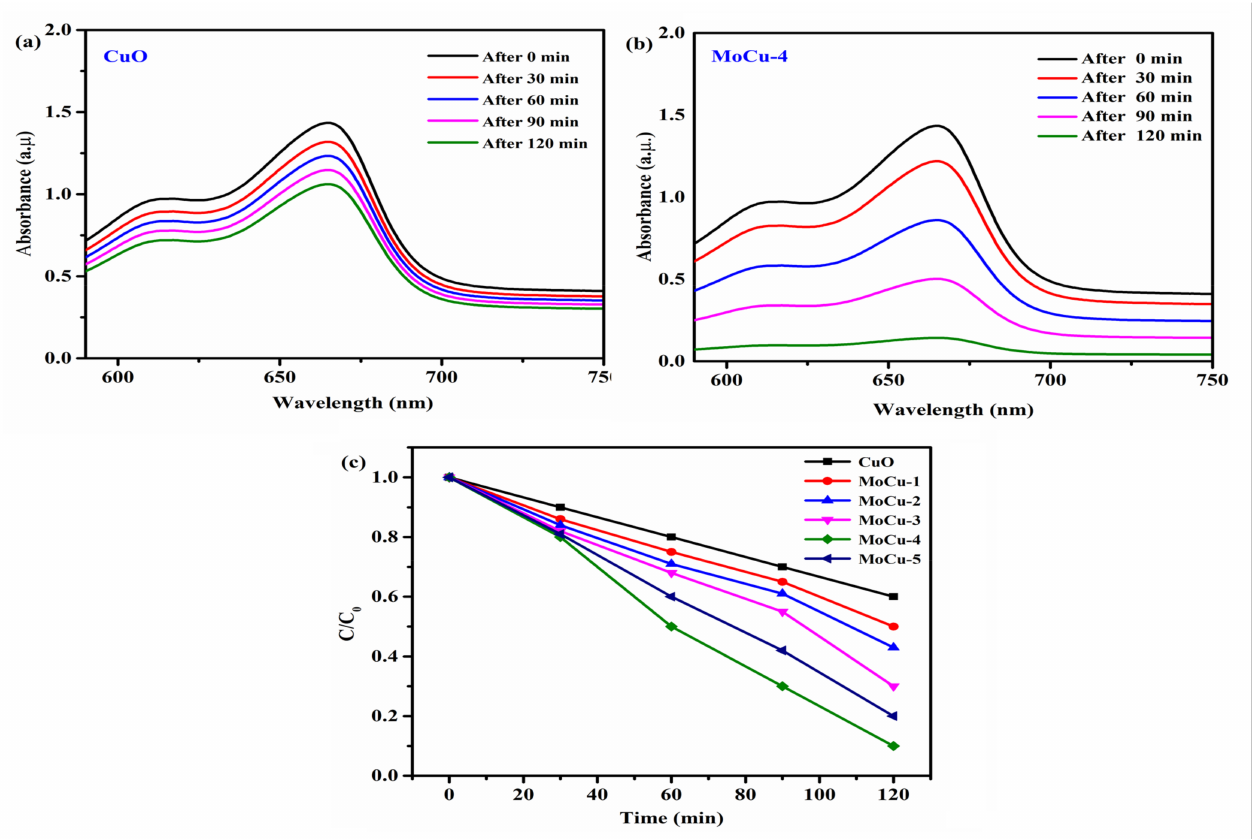
Figure 7. Photocatalytic activity absorption spectrum of ( a ) pure CuO, ( b ) MoCu-4 sample, and ( c ) photodegradation activity of pure CuO, MoCu-1, MoCu-2, MoCu-3, MoCu-4, and MoCu-5 samples. The obtained absorption spectra in the degradation of methylene blue using CuO and MoCu-4 samples are shown in Figure 7a,b. Surprisingly, the absorbance of MB